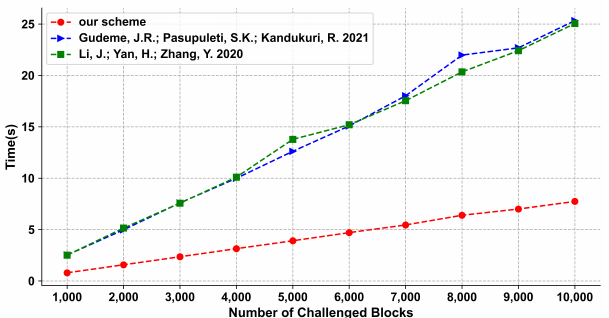
Figure 3. Computation cost of TagGen [8,15].